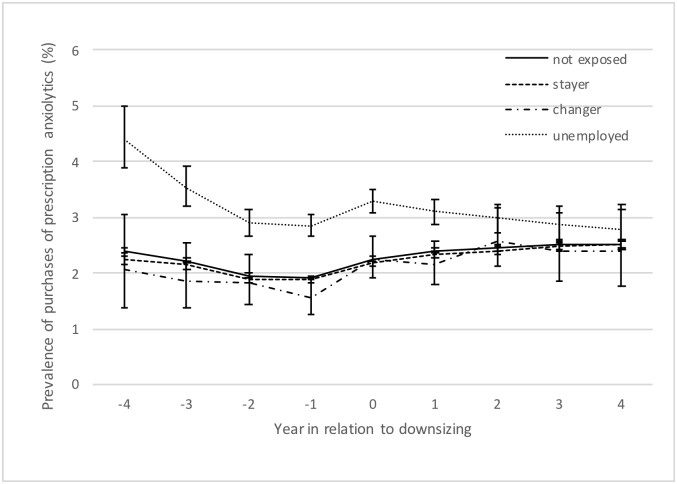
Prevalence of purchased prescribed anxiolytics among people without a previous sickness absence history.Adjusted for sociodemographic factors and with 95% CI.